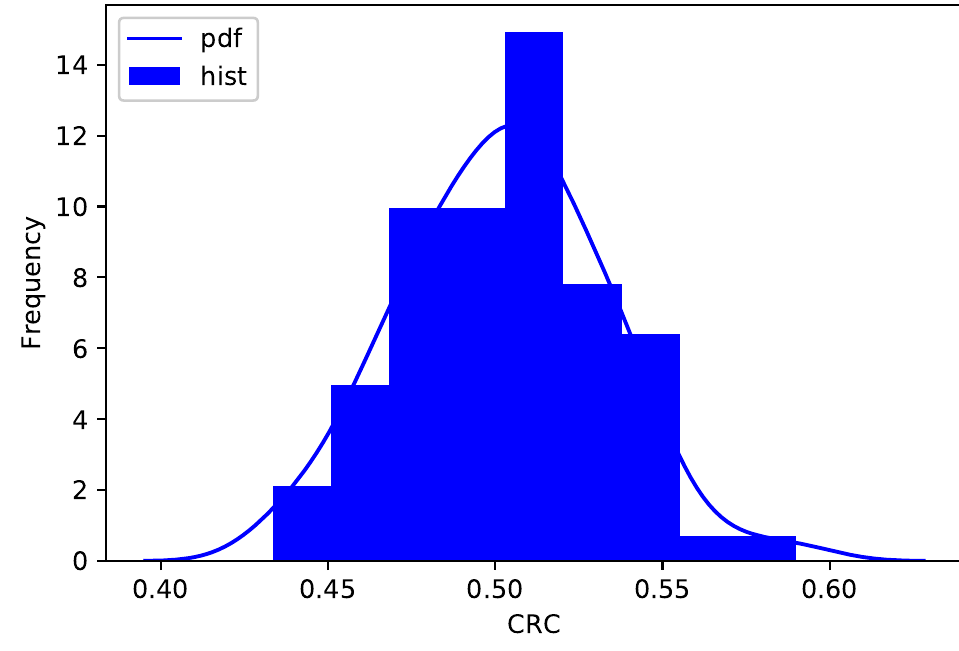
Figure 17. Plaintext sensitivity